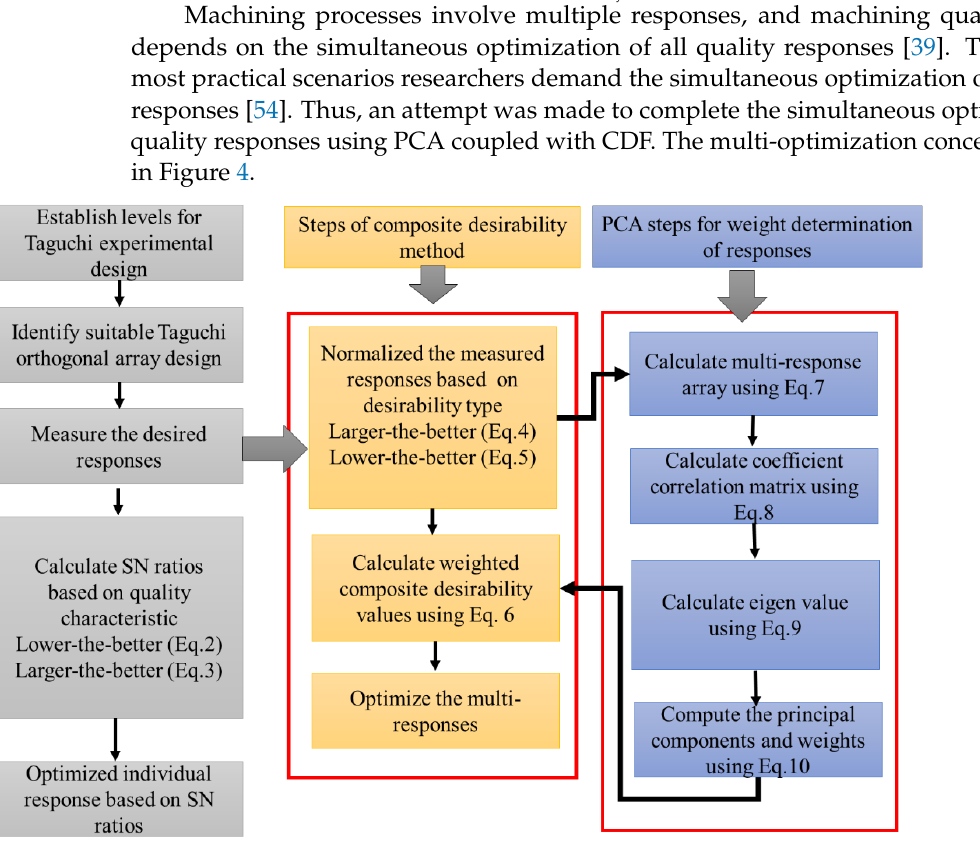
Figure 4. Conceptual framework for multi-objective optimization.